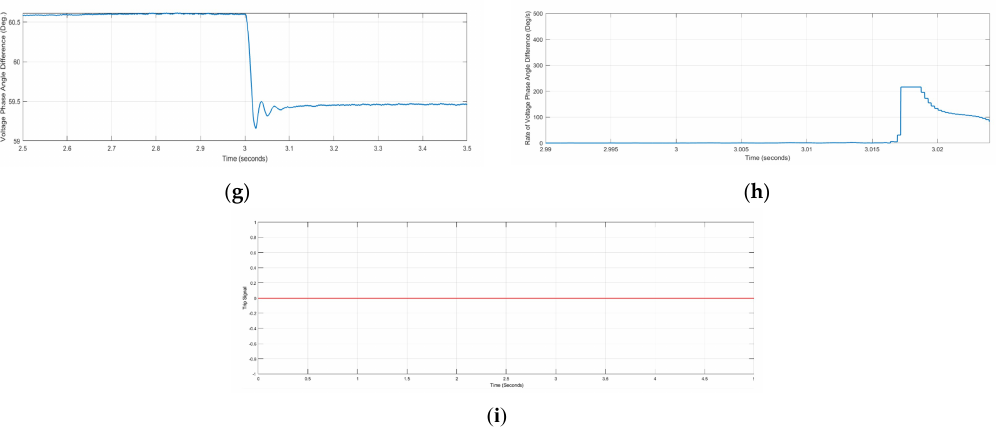
Figure 13. Results of case (v) Non-islanding condition: load shedding. ( a ) Feeder voltage; ( b ) DG voltage magnitude; ( c ) DG voltage phase angle; ( d ) ROCOV relay; ( e ) frequency relay; ( f ) ROCOF relay; ( g ) Voltage phase angle difference; ( h ) Rate of change of voltage phase angle difference; ( i )Trip Signal.